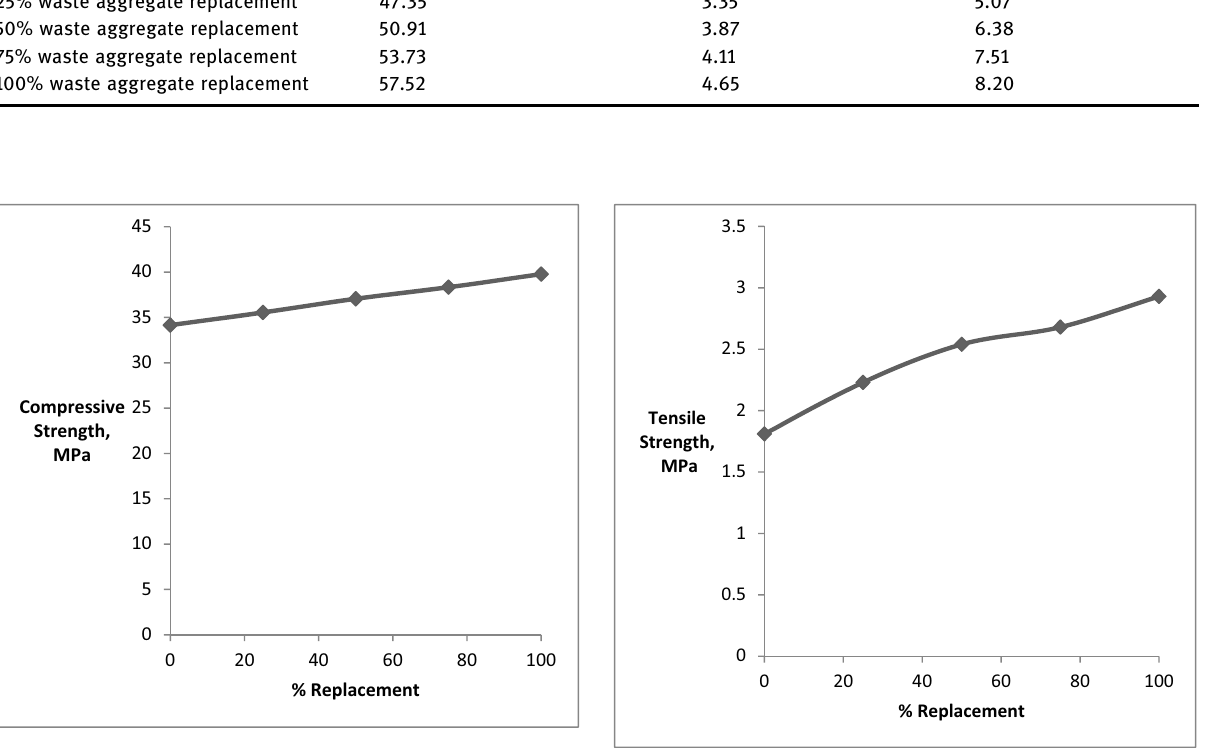
Figure 5: Relation between % replacement and tensile strength of concrete without using